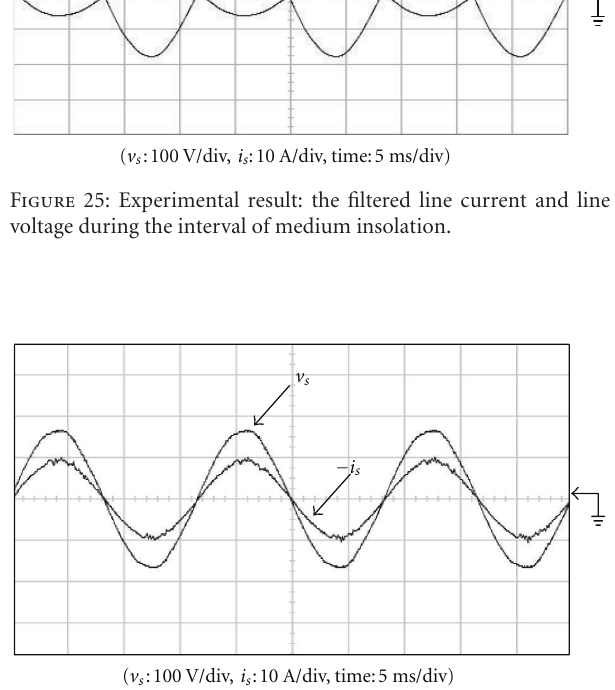
Figure 26: Experimental result: the line voltage and the filtered line current during the interval of no